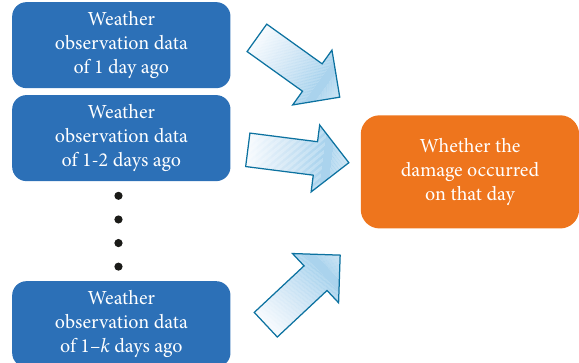
Figure 11: Algorithm 2